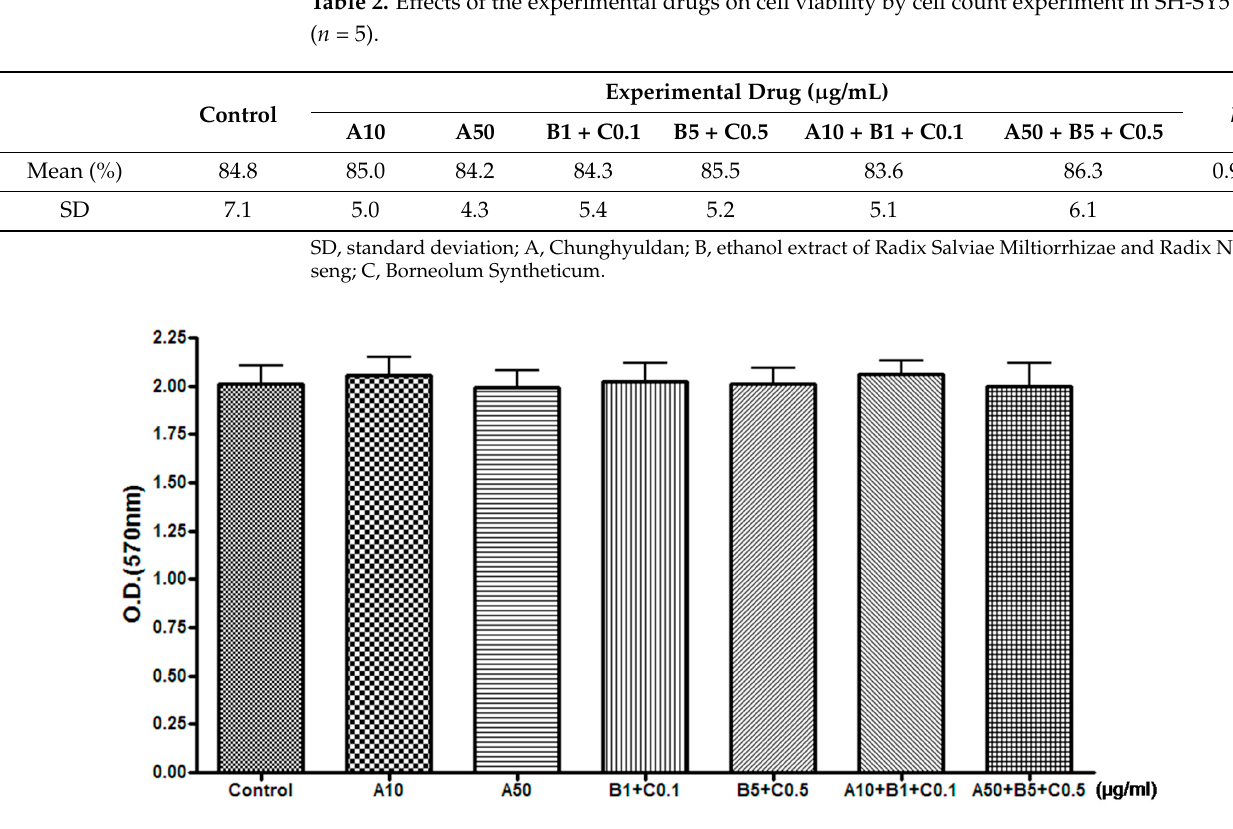
Figure 3. Effects of experimental drugs on the MTT assay results of SH-SY5Y cell viability. ( μ g/mL, mean ± standard deviation, n = 5). No significant difference in the MTT assay of cell viability was observed among groups. A, Chunghyuldan; B, ethanol extract of Radix Salviae Miltiorrhizae and Radix Notoginseng; C, Borneolum Syntheticum; O.D., optical density.